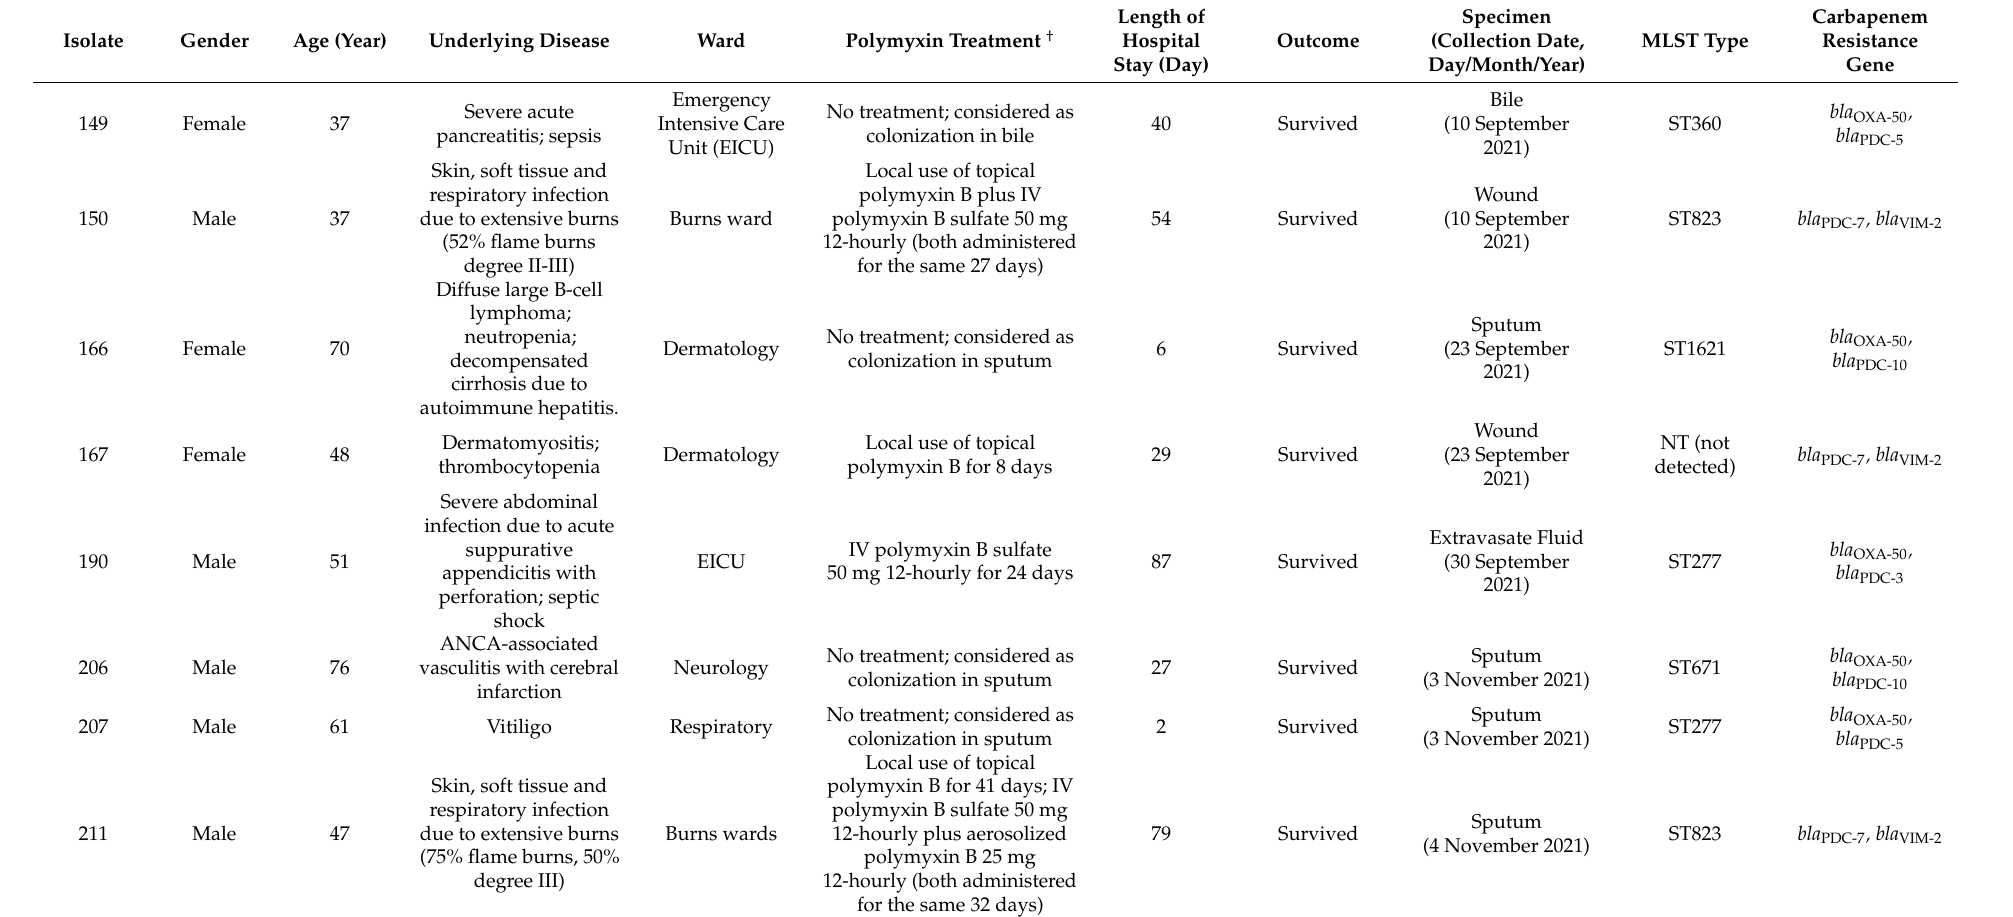
Table 1. Patient demographics and main characteristics of the polymyxin-resistant P. aeruginosa